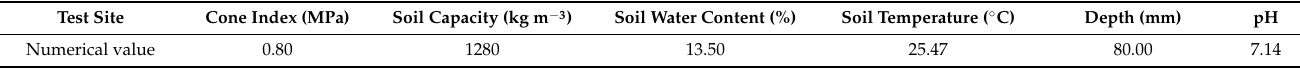
Figure 10. Su 3 entity.